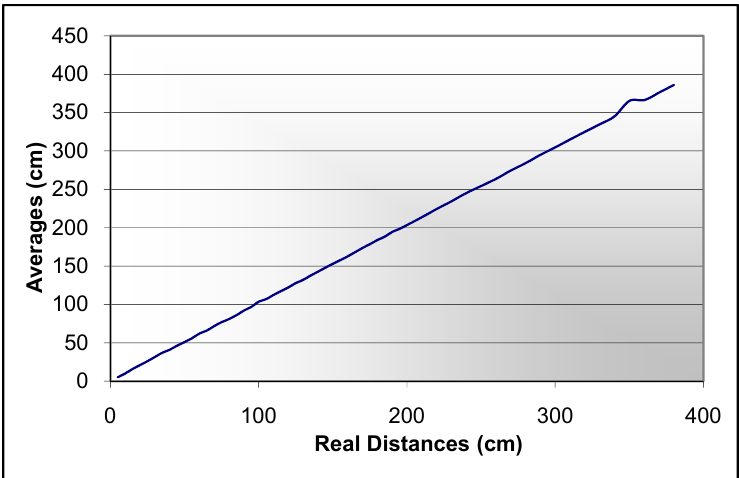
Figure 4. Averages of several samples vs . real